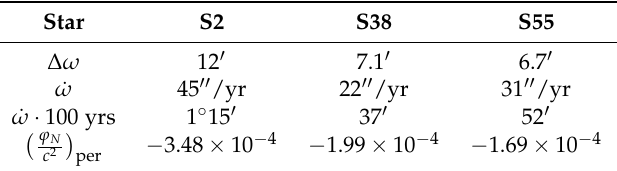
Table 1. lS-stars pericenter